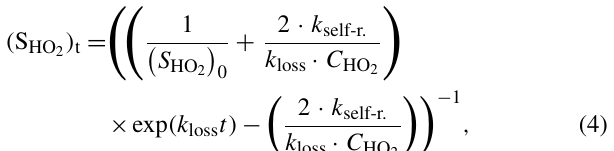
= (2.6 ± 0.5) × 10 − 7 counts cm 3 molecule − 1 s − 1 C HO 2 ∼ = C mW − 1 . Therefore, C HO HO 2 , 1000 mbar 2 , 150 mbar = (2.5 ± 0.5) × 10 − 7 counts cm 3 molecule − 1 ( ¯ C HO 2 , 1000mbar s − 1 mW − 1 ; Sect. 2.3.1), which agrees with the